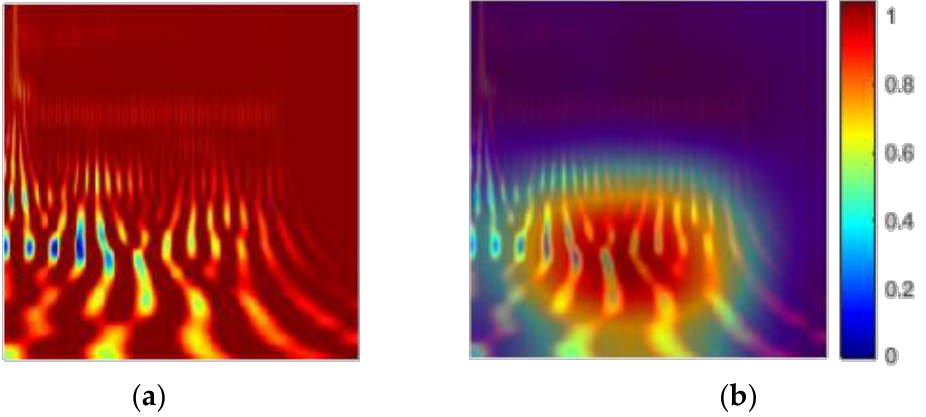
Figure 9. An example of discriminating cues from CWT images: ( a ) original image; ( b ) highlighted sensitive features.